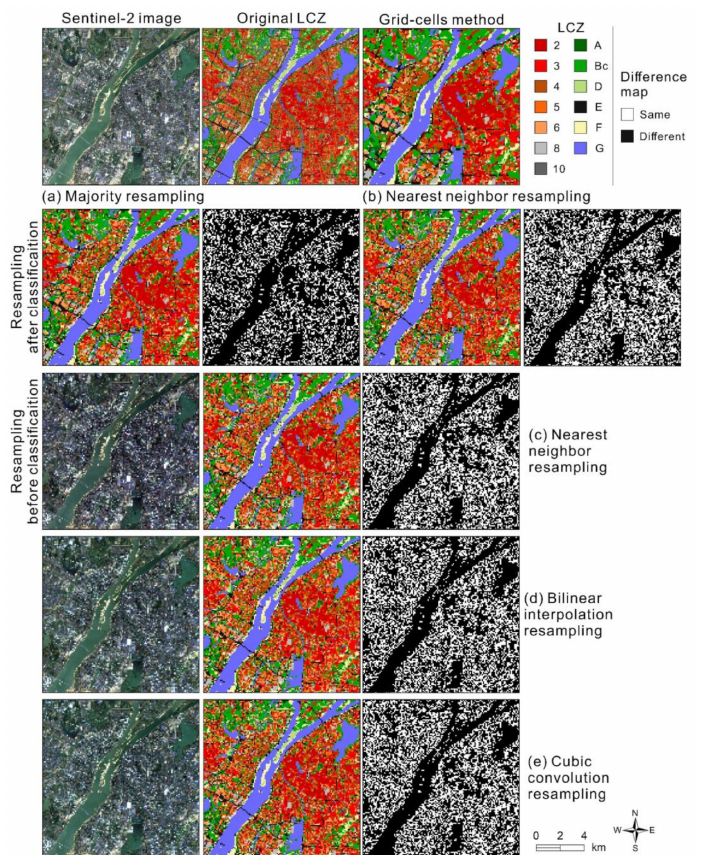
Figure 8. Detail of the comparison between the grid-cell-based method and the resampling methods using the D6 dataset. ( a ) Majority resampling after classification; ( b ) nearest neighbor resampling after classification; ( c ) nearest neighbor resampling before classification; ( d ) bilinear interpolation resampling before classification; ( e ) cubic convolution resampling before classification.